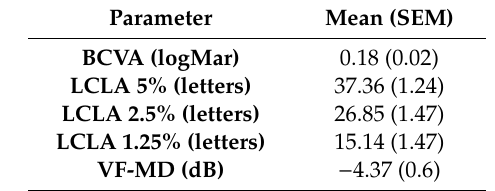
Table 1. Ocular findings in relapsing-remitting multiple sclerosis (RR-MS) patients at baseline.